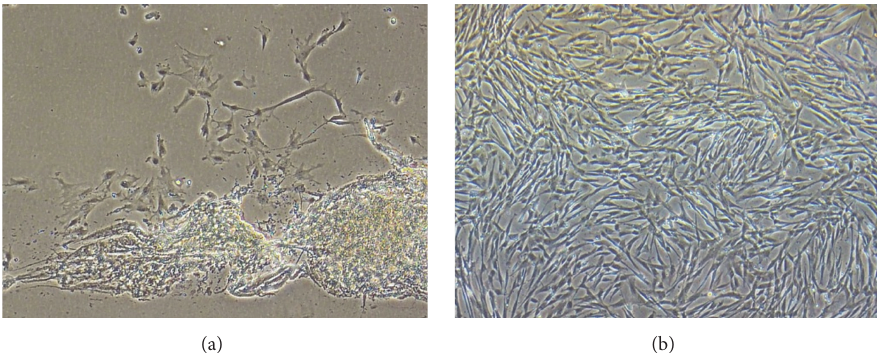
Figure 1: Morphological appearance of hUCMSCs. (a) The appearance of hUCMSCs on the fourth day of primary culture (100x). (b) hUCMSCs after the second passage are 90% confluent on the third day of culture (100x).